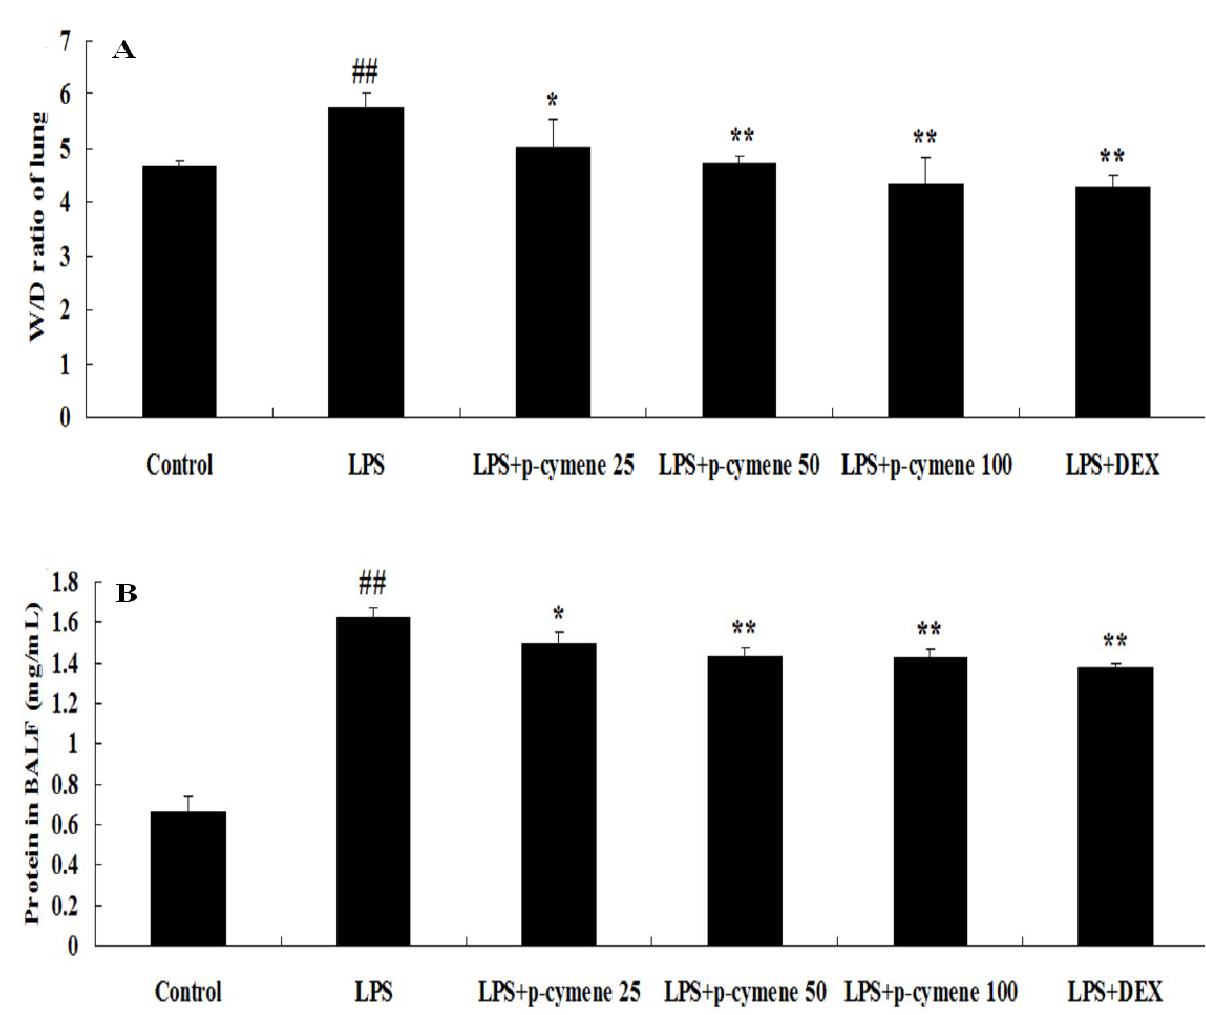
Figure 3. Effects of p -cymene on the lung W/D ratio and total protein concentration in the BALF of mice with LPS-induced ALI. Mice were given an intraperitoneal injection of p -cymene (25, 50 or 100 mg/kg) 1 h prior to an i.n. administration of LPS. The lung W/D ratio ( A ) and total protein concentration in the BALF ( B ) were determined at 7 h after LPS challenge. The values presented are the mean ± SEM (n = 6 in each group). ## p < 0.01